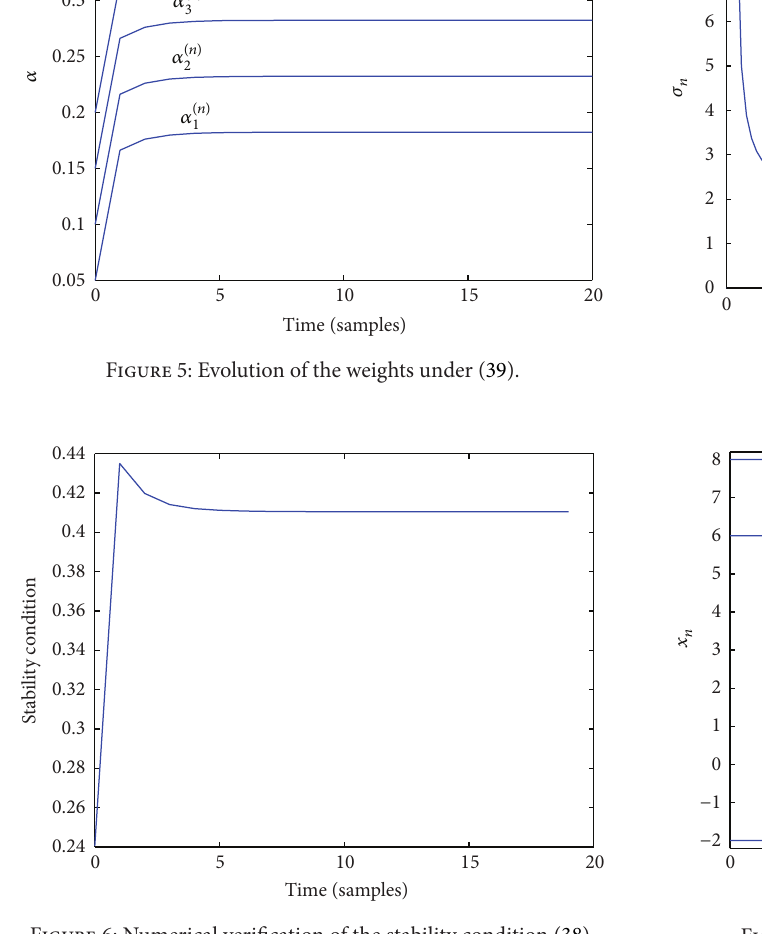
Figure 6: Numerical verification of the stability condition (38).